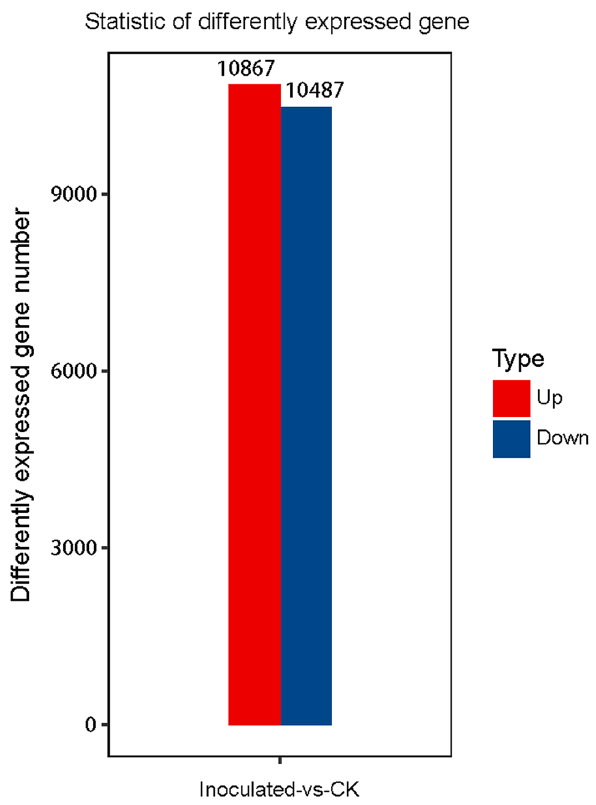
Figure 4. Significant differentially expressed genes (DEGs) in T. controversa -infected vs. mock libraries. Up- or downregulated DEGs in response to T. controversa infection. CK indicates mock plants, and Inoculated indicates plants infected by T.